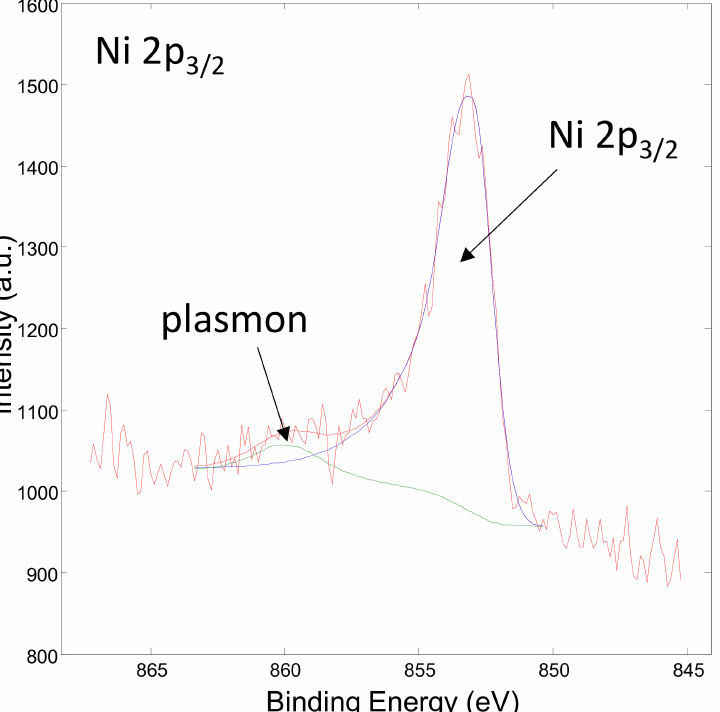
Figure 11. XPS spectrum of Ni 2p obtained after removing the 10-nm thick layer on the concentrated sample Ni/Y 2 O 3 -0.025/0.100.